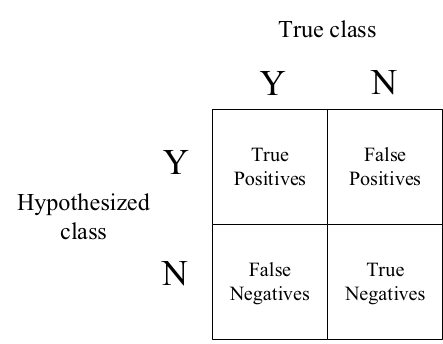
Fig. 9 Schematic diagram of evaluation